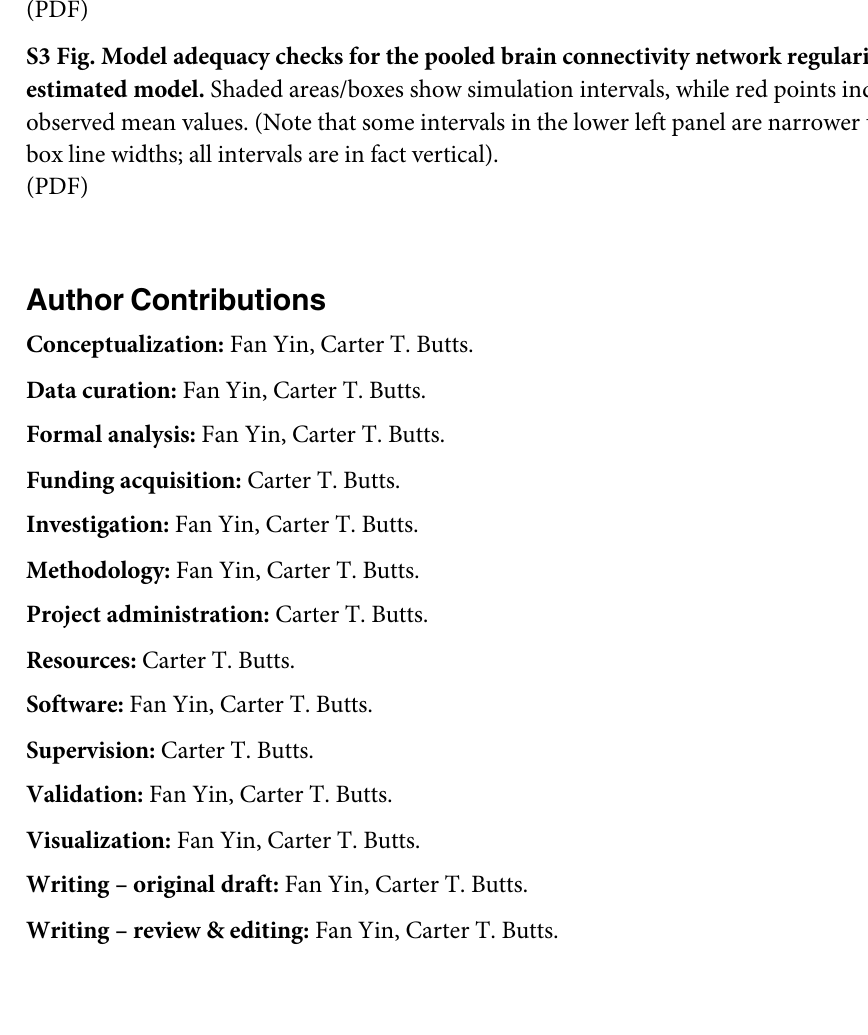
S1 Fig. Model adequacy checks for the pooled brain connectivity network ML-estimated model. Shaded areas/boxes show simulation intervals, while red points indicate observed mean values. (Note that some intervals in the lower left panel are narrower than box line widths; all intervals are in fact vertical). S2 Fig. Model adequacy checks for the pooled brain connectivity network MAP-estimated model. Shaded areas/boxes show simulation intervals, while red points indicate observed mean values. (Note that some intervals in the lower left panel are narrower than box line widths; all intervals are in fact vertical). S3 Fig. Model adequacy checks for the pooled brain connectivity network regularized ML- estimated model. Shaded areas/boxes show simulation intervals, while red points indicate observed mean values. (Note that some intervals in the lower left panel are narrower than box line widths; all intervals are in fact